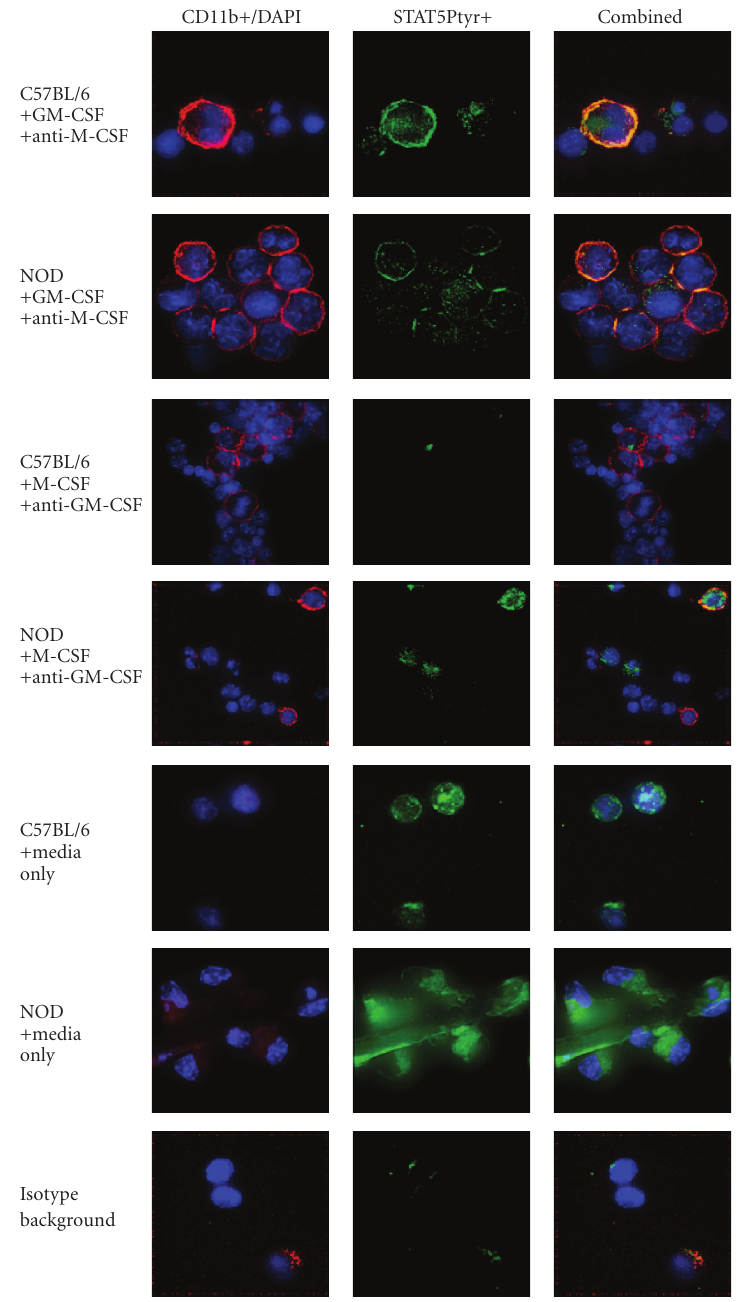
Figure 2: GM-CSF/M-CSF cytokine-induced myeloid di ff erentiation in vitro . Bone marrow cultures from NOD and C57BL/6 control mice were di ff erentiated in culture using regiment of cytokine and anticytokine blocking antibodies. Cells were treated with either 1000 U/mL GM-CSF plus 2 μ g/mL anti-M-CSF blocking antibodies, with 500 U/mL M-CSF plus 2 μ g/mL anti-GM-CSF blocking antibodies, or with media alone for 48 hours at 3 ◦ C/5CO 2 . Cells were stained with anti-STAT5Ptyr-FITC (green) and anti-CD11b-PE (red) antibodies for analysis by flow cytometry (summarized in Figure 1) and deconvolution microscopy (shown here) for the development of cells with myeloid phenotype (CD11b+) and intracellular expression of tyrosine phosphorylated STAT5. Background staining for anti-STAT5Ptyr-FITC antibody was determined by parallel sample stained with a nonspecific mouse IgG isotype control (bottom most panels). The images are composites of 3D projection of 20 optical sections (0.2 micron each) showing both immunohistochemical labels as well as DAPI (blue) poststaining of chromatin within the cells. Accompanying panels show the STAT5Ptyr-FITC staining alone (green) or CD11b-PE and DAPI staining (red/blue). Treatment regiment and the cell source strain for each pair of cultures are listed to the left of the images. Images are representative of 5 random fields observed per sample treatment and 3 separate runs of the